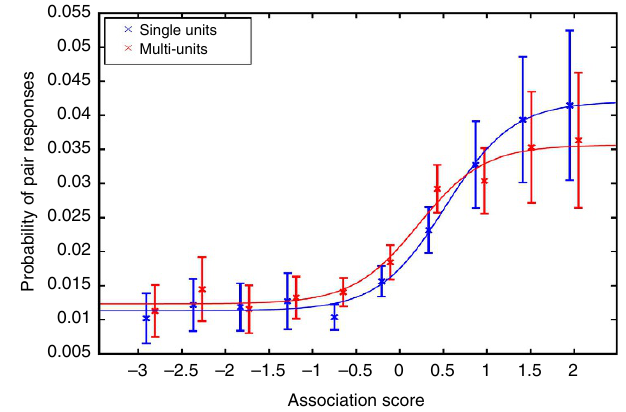
Figure 5 | Probability of responses to associated concepts. Probability of responses to a pair of pictures as a function of their degree of association (see text for details). Error bars